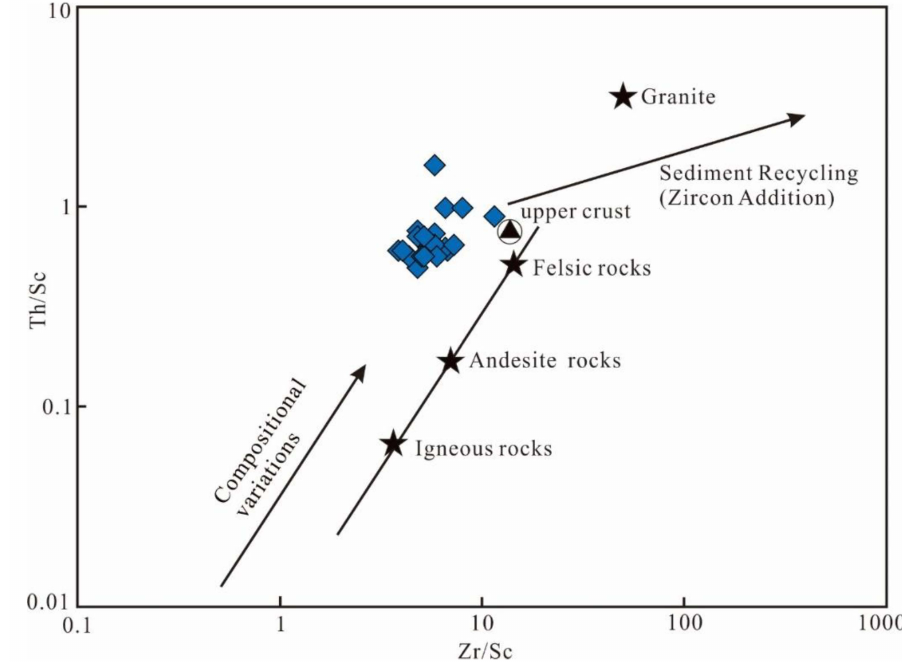
Figure 16. Th/Sc versus Zr/Sc bivariate diagram [10] showing the influence of weathering, sorting and recycling processes for sandstones from the Zhiluo